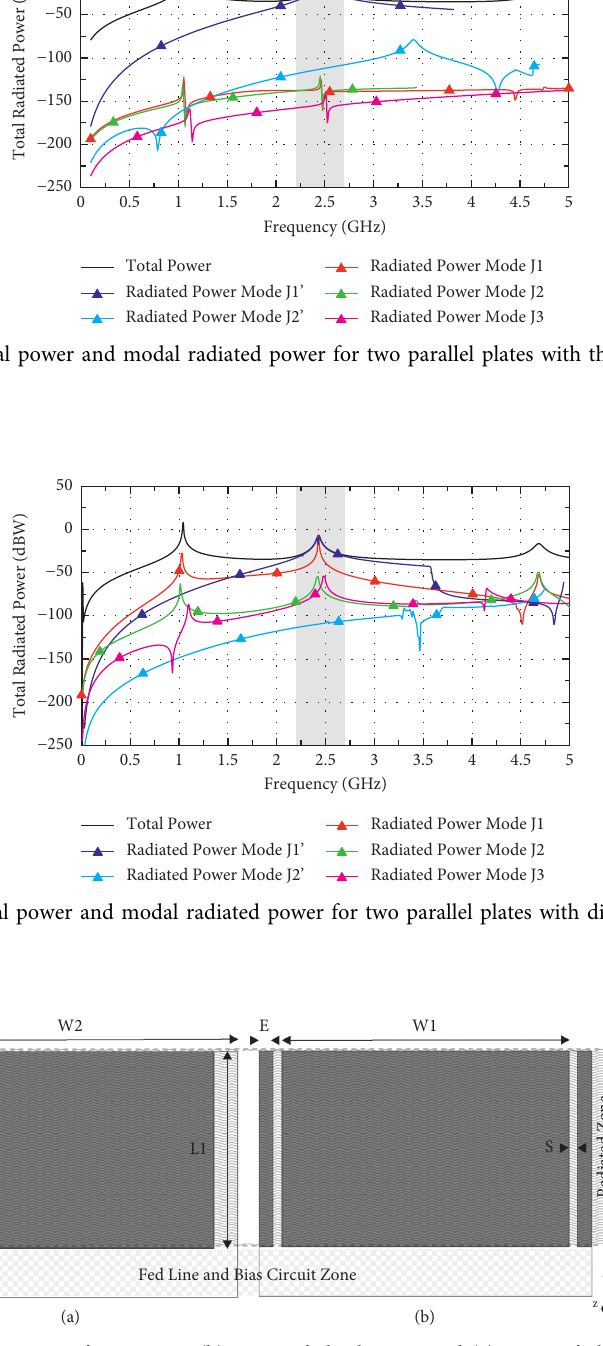
Figure 8: (a) Antenna’s top view, (b) antenna’s back view, and (c) antenna’s lateral